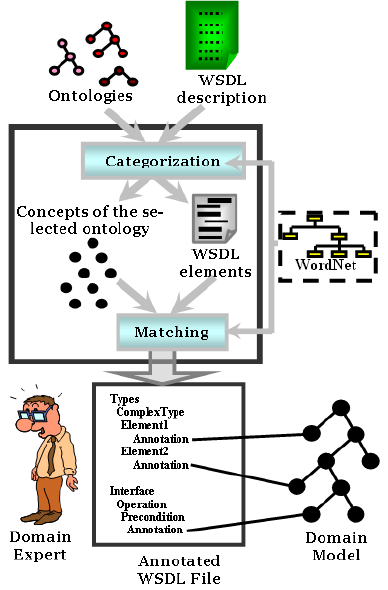
Fig. 1. SAWSDL Generator Architecture (See Ref.